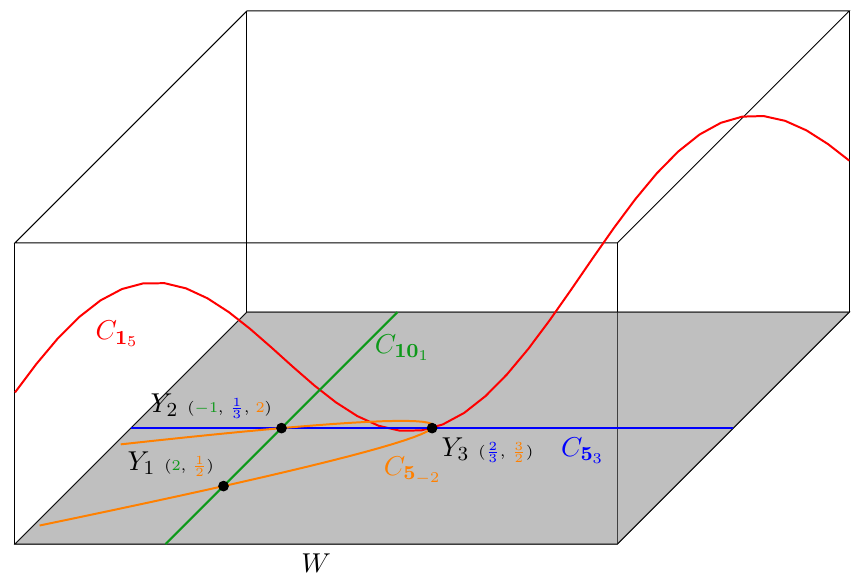
, C 5 , C 5 1 3 (cid:0) 2